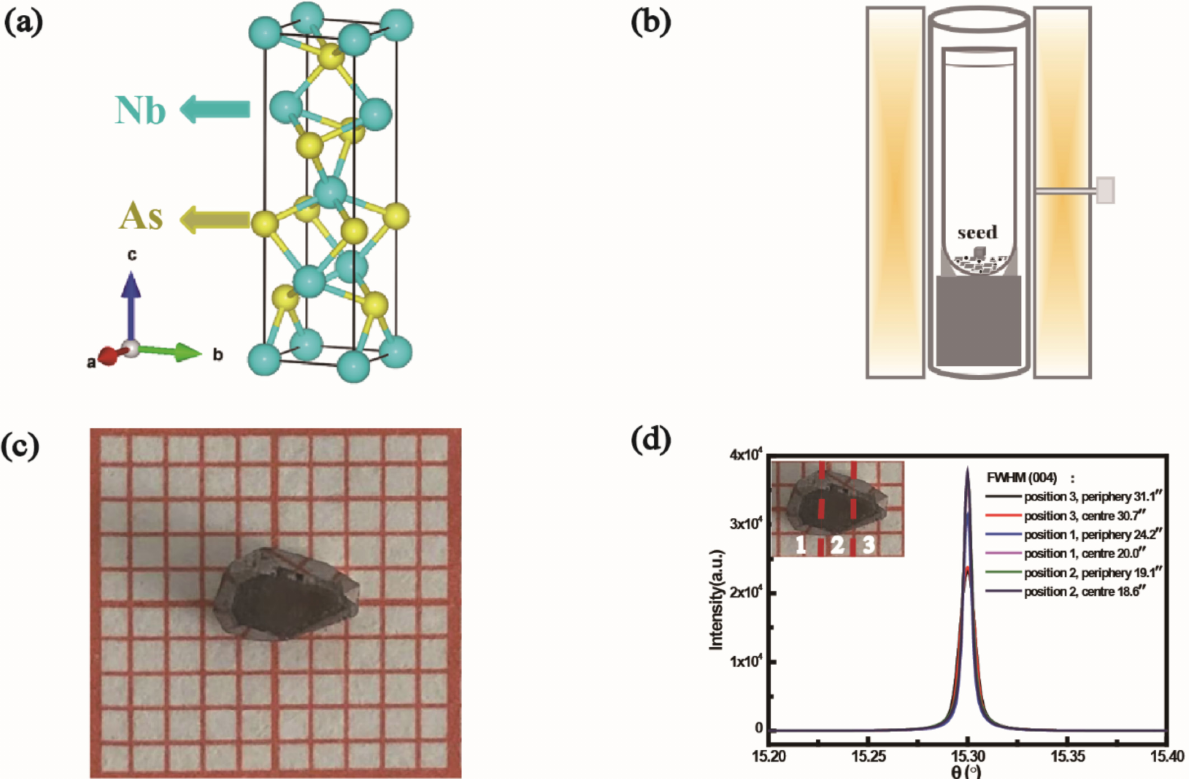
Figure 1. ( a ) Crystal structure of NbAs. ( b ) Schemes of the chemical vapor transport experiments for crystallization of NbAs in a two-step method. ( c ) Photograph of NbAs single crystal. ( d ) X-ray rocking curves of the three different regions (as shown in the illustration) for (004) face show good crystallinity with Full Width at Half Maxima (FWHM) less than